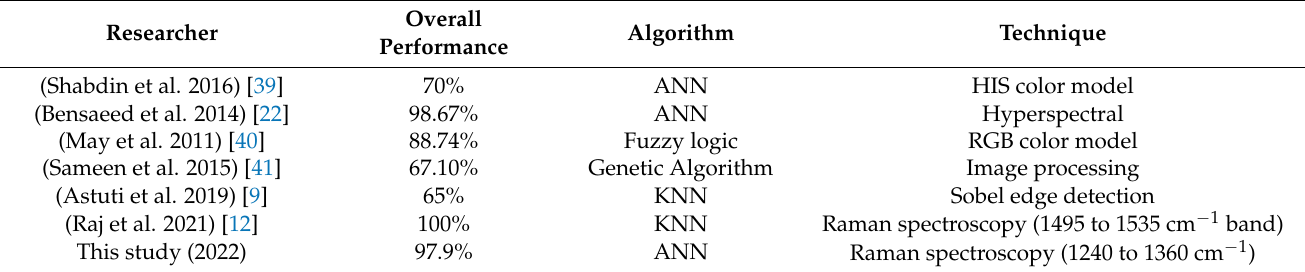
Figure 9. All Confusion Matrix generated from ANN model based on seven significant features. Table 6. Classification results from previous researchers and this study.